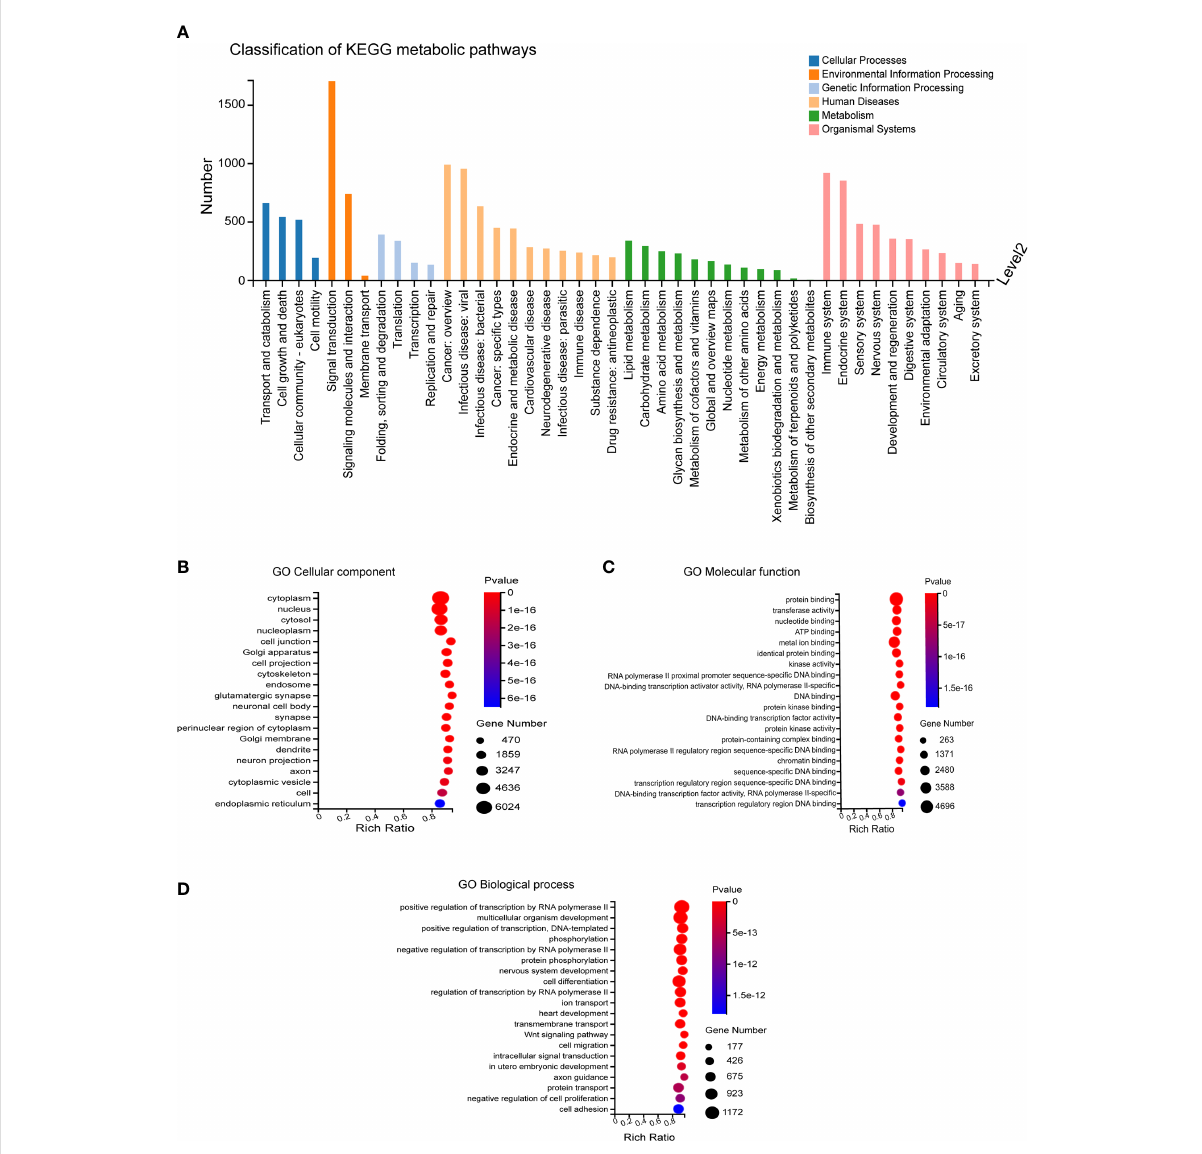
FIGURE 3 GO Enrichment. (A) Biological processes involved in the differentially expressed miRNA-regulated predicted target genes. (B – D) Cellular components, molecular functions and biological processes involved in the differentially expressed miRNA-regulated predicted target